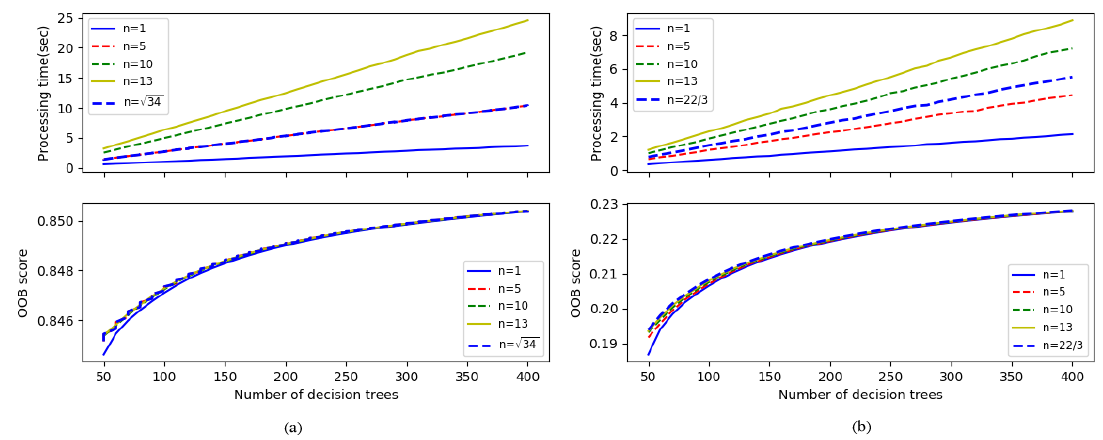
Figure 5. Results of the tuning procedure: ( a ) RF classification (rain area), ( b ) RF regression (rainfall), both in February. n = the number of input